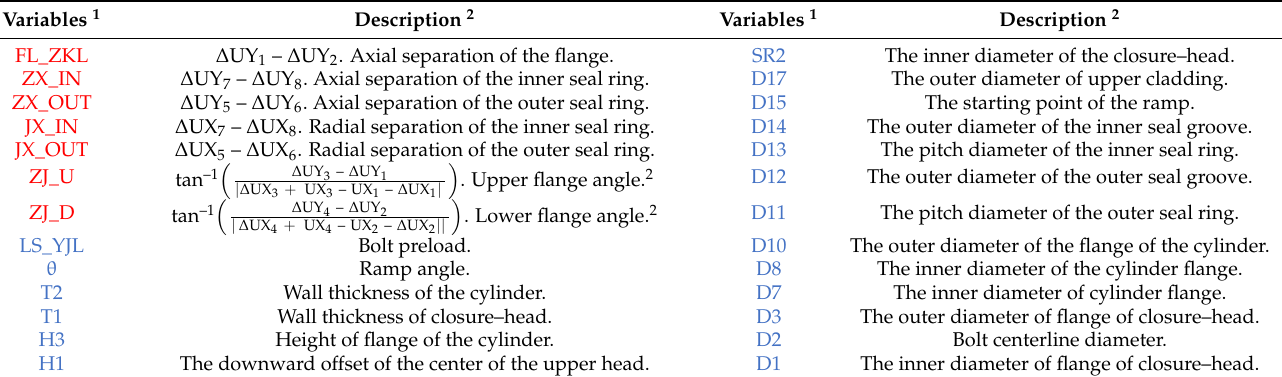
Table 1. Description of